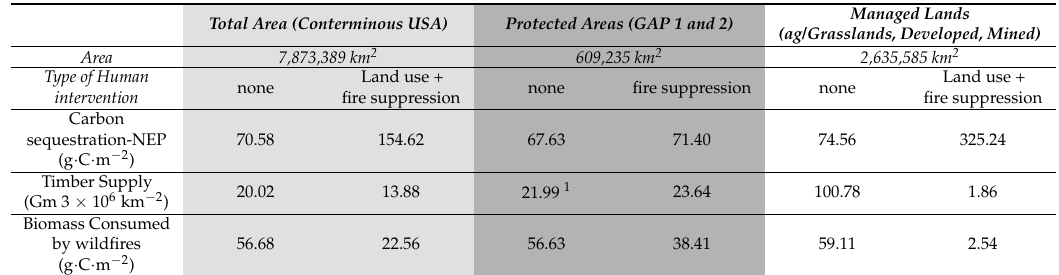
Figure 1. Simulated forest carbon stocks and forest vigor (NPP/LAI) for historical conditions (1971–2000) and for future conditions across 3 possible futures (climate projections from CGCM3, MIROC and CSIRO) under the A2 emission scenario (2041–2070). We show simulation results at 30 arcsec spatial resolution for mid-century with and without land use and fire suppression. Table 1. Simulated ecosystem services and their constraints for the conterminous USA using results from the MC2 model at 30 arcsec spatial resolution for the period 2041–2070 across 3 climate futures (CGCM3, CSIRO and MIROC) under the A2 emission scenario.